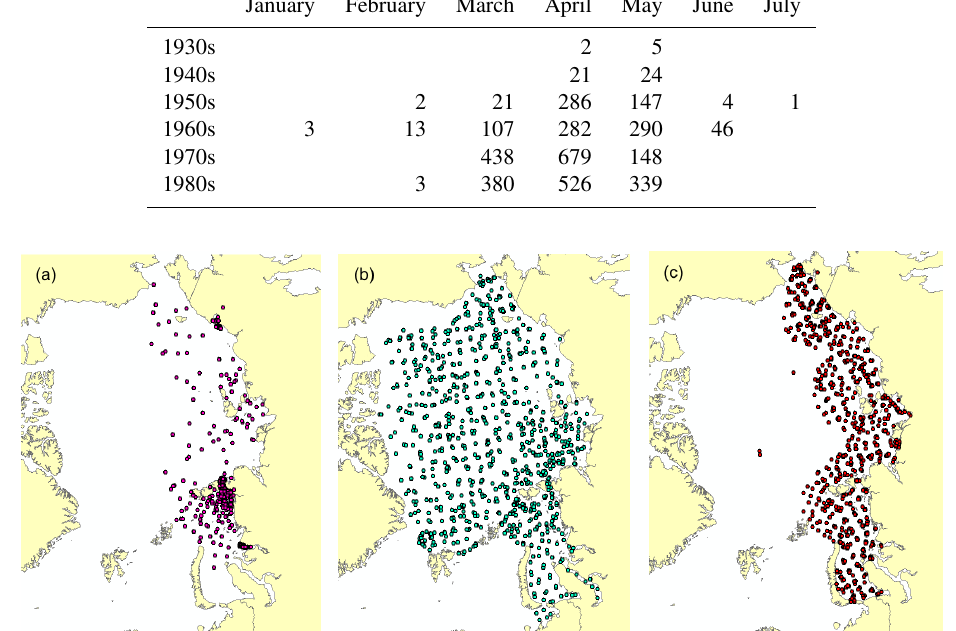
The Sever and NP expeditions had different data collection strategy regarding not only spatial and temporal sampling, but also in the way snow observations were